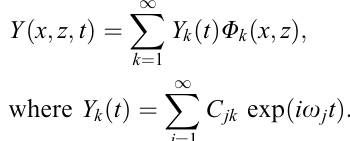
( lower panel ) and 1 and Y have been scaled by a common factor, 1 2 is approximately equal to 1